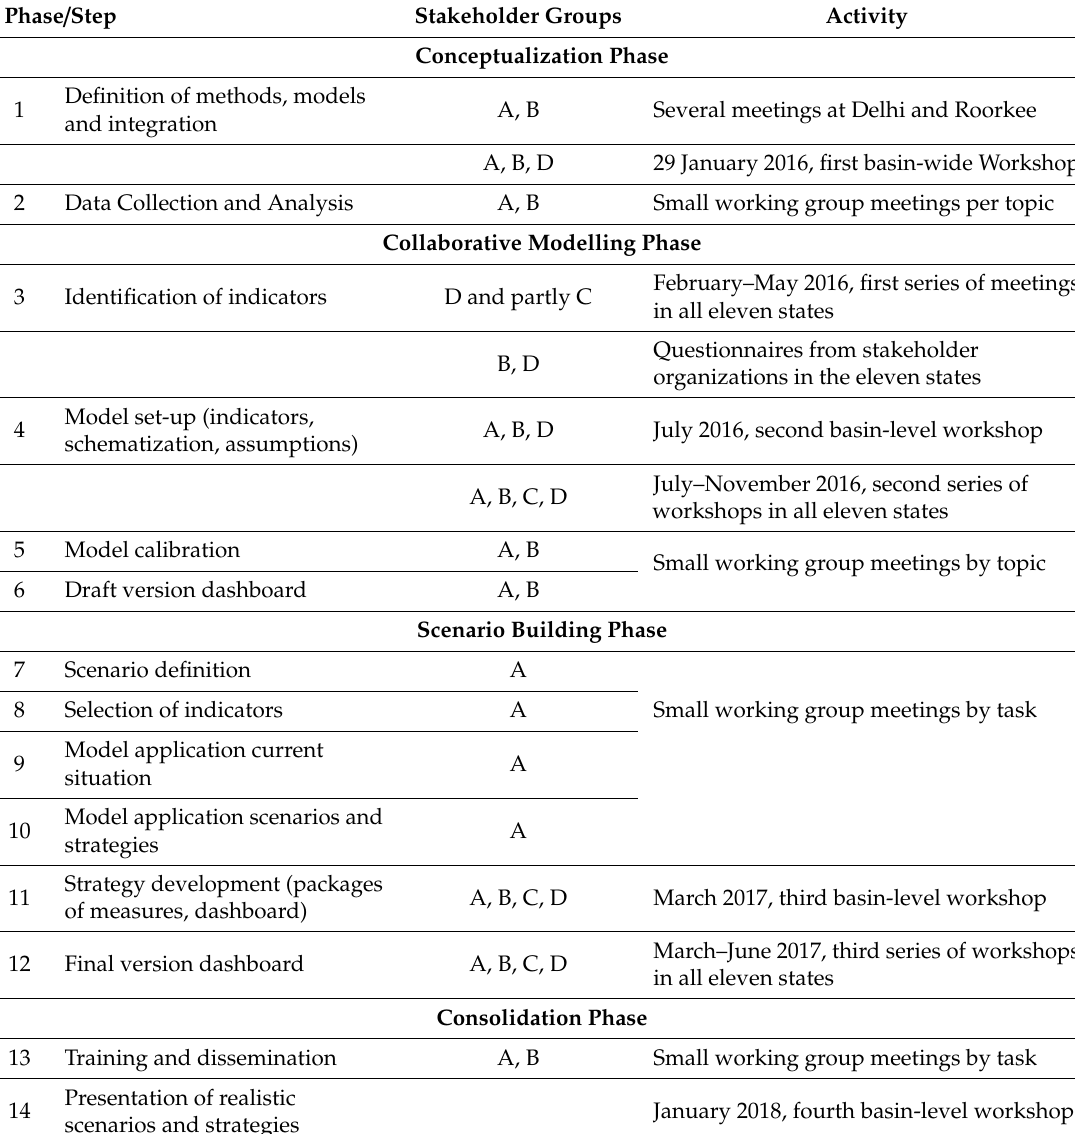
Table 1. Summary of steps in stakeholder engagement (A = Model Developers; B = Model Users; C = Interested Parties; D = Decision